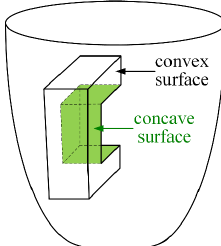
Figure 1. An example of a convex ( left ) and a concave ( right ) surface with surface normals denoted by arrows.